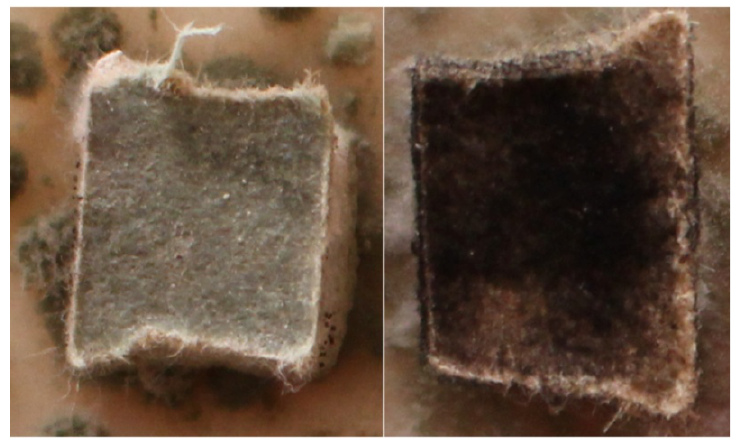
Figure 3. Sample 1 after 14 (left) and 22 (right) days.